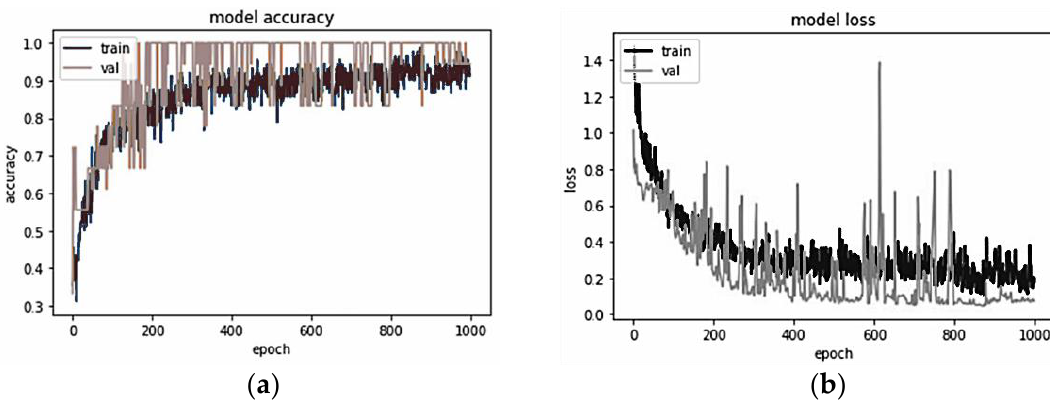
Figure 3. The performance of the proposed ANN model during training and validation using the T1 dataset. ( a ) graph of model accuracy is the number of classifications that is successfully predicted, divided by the total number of predictions; ( b ) graph of model loss indicates how bad the model’s prediction is. Train, the model training indexed by the black line; Val, the model validation indexed by the grey line; T1, first toe.